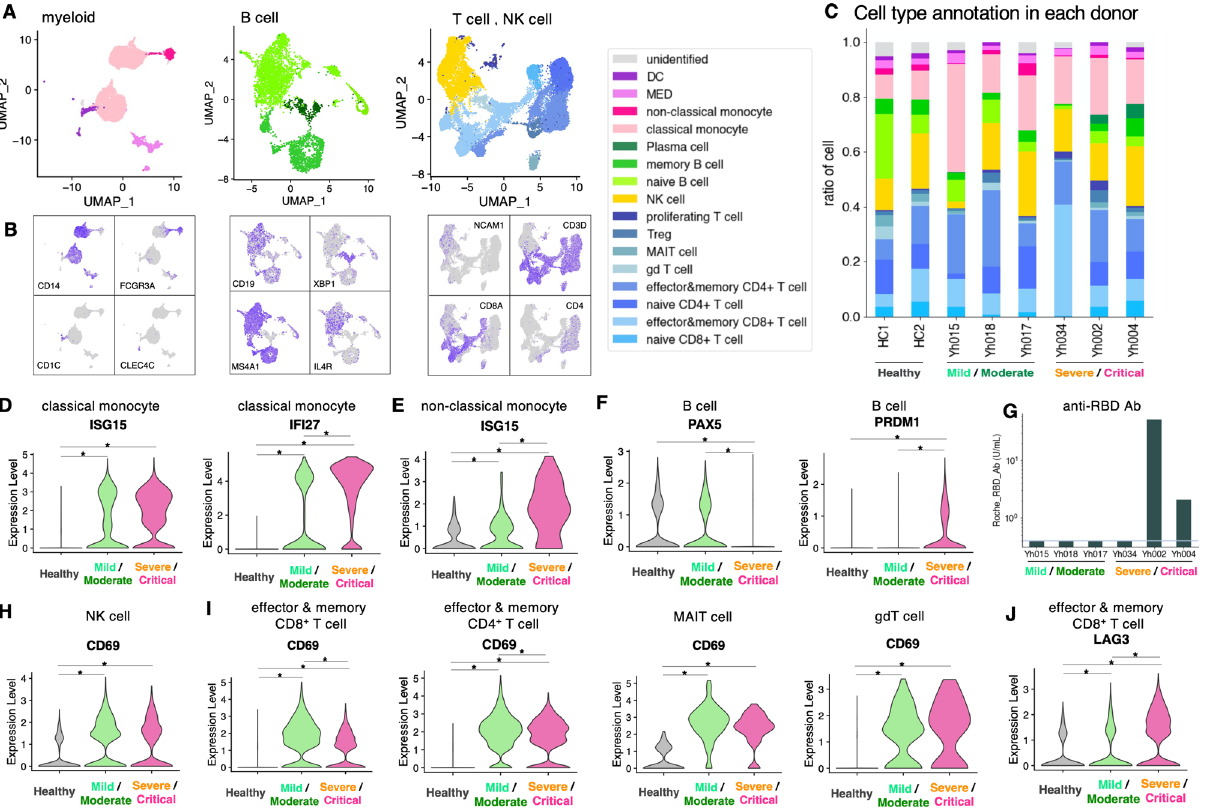
Figure 2. Severity-dependent character in COVID-19 patients. (A) Annotation of cells used in the severity dependent study of myeloid (classical monocyte, non-classical monocyte, MED, and DC), B cell (naïve B cell, memory B cell, and Plasma cell), and T cell and NK cell (naïve CD8 + T cell, effector & memory CD8 + T cell, CD4 + naïve T cell, CD4 + effector & memory T cell, gd T cell, MAIT cell, Treg, proliferating T cell and NK cell) shown in UMAP. Color legends are shown in the margin. (B) Feature plots of representative markers for myeloid, B cell, T cell, and NK cell. Detailed information of annotation is shown in Supplementary Figs. S1, S2, S3 and the methods. (C) Proportion of cells present in each case. Bar plot shows cell proportions in healthy donors and COVID-19 patients. Color legends the same as (A) . (D, E) Expression level of inflammatory genes in classical monocytes (D) and non-classical monocytes (E) . (F) Expression levels of PAX5 and PRDM1 in B cells. (G) SARS-CoV-2 anti-RBD antibody levels in patients. The x-axis shows the patient, and the y-axis shows antibody levels (U/ mL). Red line shows the limit of detection (0.4). (H, I) Expression of activation marker CD69 in NK cells (H) , and effector & memory CD8 + T cells, effector & memory CD4 + T cells, MAIT cells and gd T cells (I) . (J) Expression of exhaustion marker LAG3 in effector & memory CD8 + T cells. In the violin plot ( D – F ) and ( H - J ), the healthy group includes cells from two control cases (HC1 and HC2), mild/moderate from three cases (Yh015, Yh018, and Yh017), and severe/critical from three cases (Yh034, Yh002, and Yh004). Statistically significant differences are marked with * (p < 0.05, Wilcoxon Rank Sum ies were utilized for libraries construction so that the cell barcodes could be shared between the scVDJ-seq and scRNA-seq libraries (Fig. 1A). The possible epitopes of SARS-CoV-2 for each TCR were predicted by the reference epitope database, TCRex 23 . An average of 1.2% of the annotated T cells were predicted to express TCR, which may recognize peptides derived from SARS-CoV-2 proteins (Fig. 3A and Supplementary Table S2). In all COVID-19 cases, the major predicted target region of T cell recognition was ORF1ab. However, it also predicted that 1.3% of T cells (1.6% for HC1, 1.0% for HC2) in healthy controls to recognize SARS-CoV-2 protein and most frequent target was ORF1ab (Fig. 3A and Supplementary Table S2). This prediction is based only on the TCR sequence, not on the function of the T cell. Therefore, the number of SARS-CoV-2-specific T cells was quantified using IFN-γ ELISpot assays and compared to the predicted number of SARS-CoV-2-specific TCRs in each patient (Fig. 3A, B). A mixture of overlapping peptides encoding the entire proteome of SARS-CoV-2 (except ORF1ab) was used for the ELISpot assay. The samples with higher numbers of predicted TCRs for S/M/N/ORF3/ORF6 according to epitope predictions (Yh018 and Yh002) also showed relatively higher numbers of IFN-γ-producing T cells in ELISpot assays, suggesting that the results of epitope predictions should be reasonably reliable, even if individual TCR results need to be further evaluated.